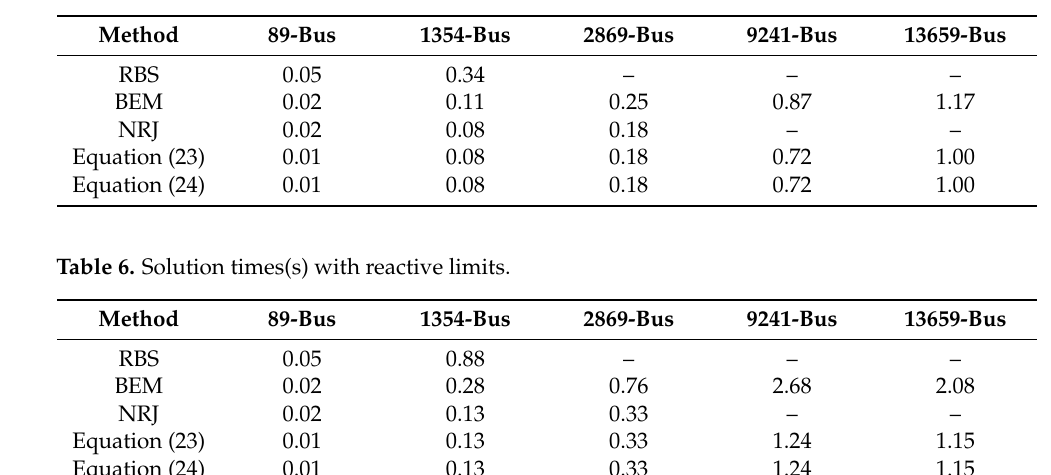
Table 5. Solution times(s) for base cases.